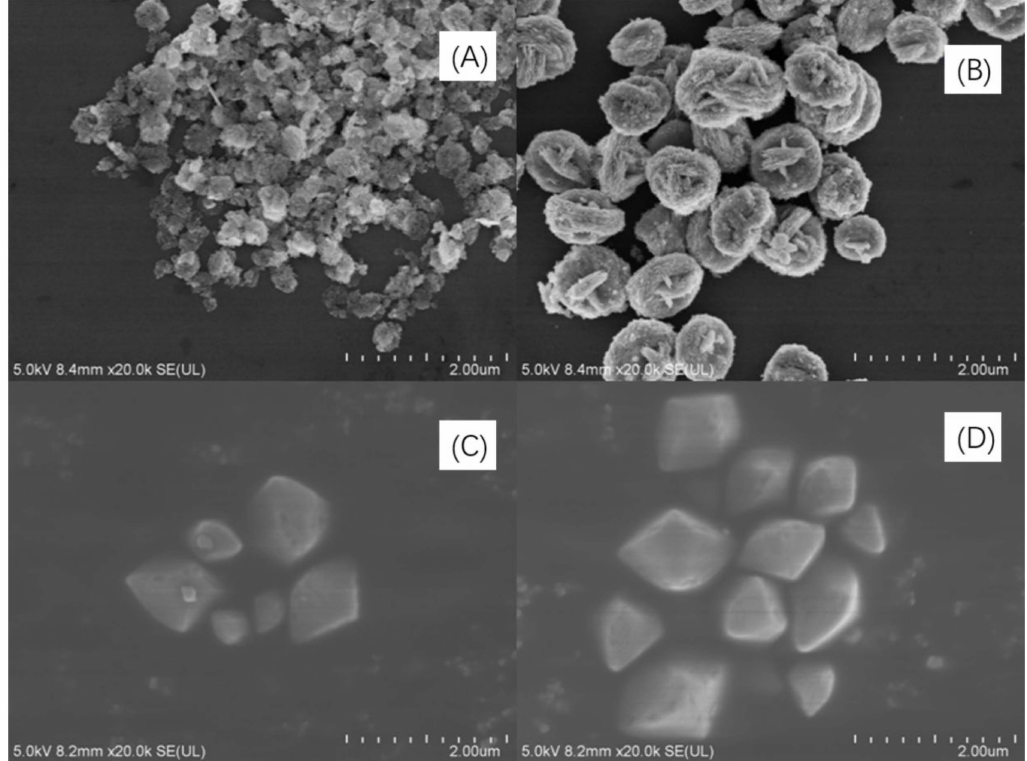
Figure 3. SEM images of ( A ) Bi 2 WO 6 , ( B ) Bi 2 W 2 O 9 , ( C ) Bi 2 MoO 6 and ( D ) Bi 2 Mo 2 O 9